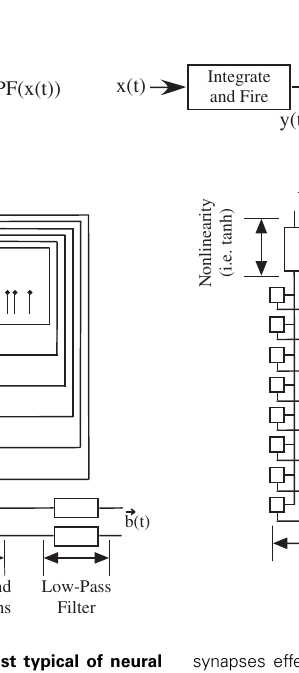
synapses effectively perform a low-pass filter on the resulting input event stream, particularly for rate encoded outputs. This model breaks down for low event rates, particularly for place coding; this case is rare for such networks which are based upon integrate and fire based neurons that are resulting in rate encoded signals. Typically, dealing with continuous-valued elements has similar implementation complexity and lower power consumption; The primary operation in either case is a Vector-matrix multiplication (VMM), with similar complexity in either case. One might find particular niche applications where one structure can be optimized over the other approach. The non-linearity block for the ANN approach might be a time-dependant non-linearity; for Hodgkin–Huxley type neurons, the resulting function resembles more of a bandpass filter function. The mesh architecture approach enables direct computing through